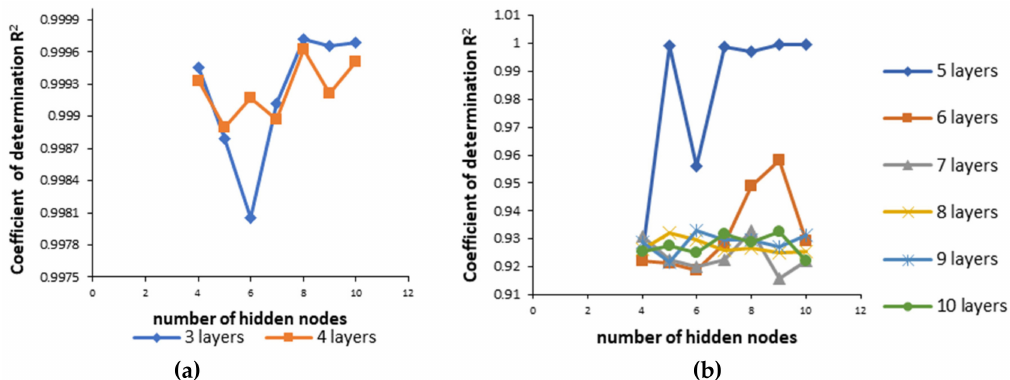
Figure 5. Coe ffi cient of determination ( R 2 ) for neural network 1 with di ff erent numbers of hidden nodes and layers ( a ) for 3 and 4 layers ( b ) for 5 to 10 layers.